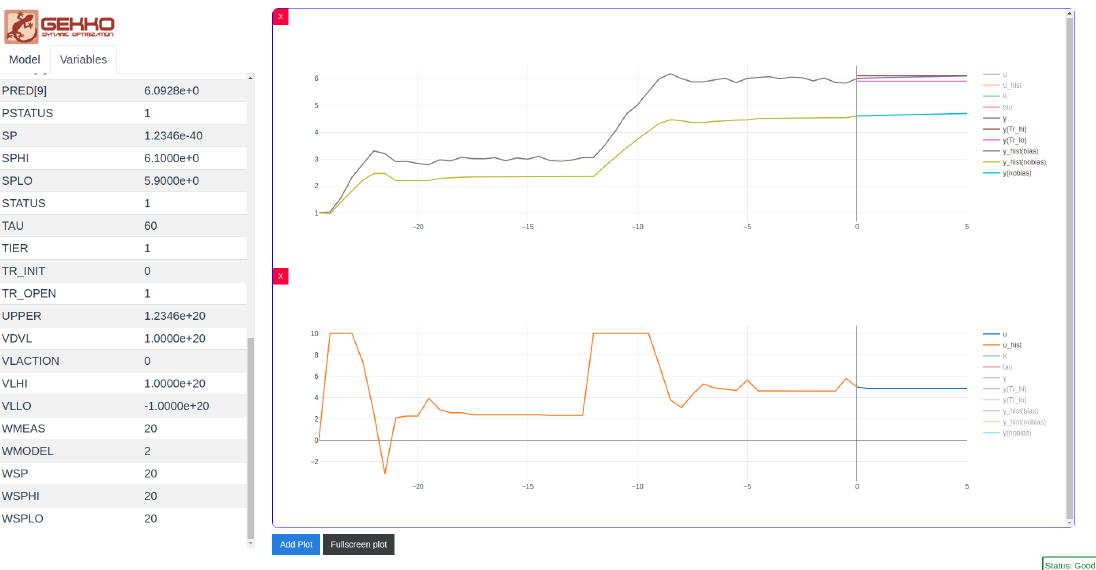
Figure 2. Sample GEKKO GUI screen for rapidly visualizing